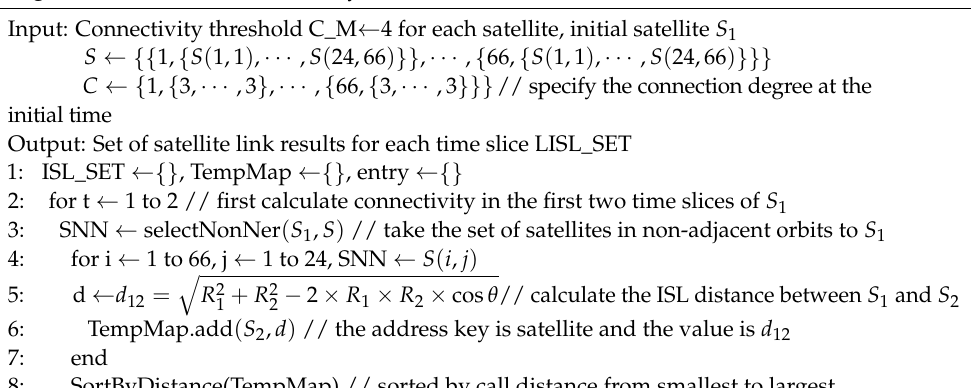
Algorithm 1 Pseudocode for the dynamic link